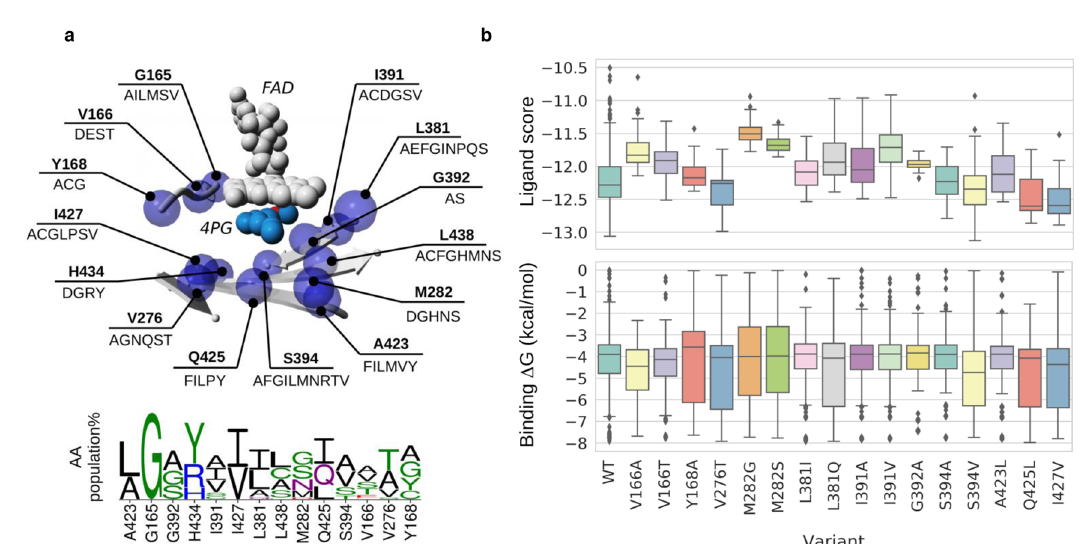
Fig. 3 | Computational analysis for improving activity. a The positions at the EUGOactivesiteselectedformutagenesis(bluespheres)andthechangesobserved in every position according to a multiple sequence alignment (top). The FAD cofactorand the 4- n -propylguaiacol (4PG) ligand are representedasgray and light blue balls, respectively. Residues selected by the Monte Carlo algorithm for every position in the Rosetta Coupled Moves experiment are indicated (bottom).